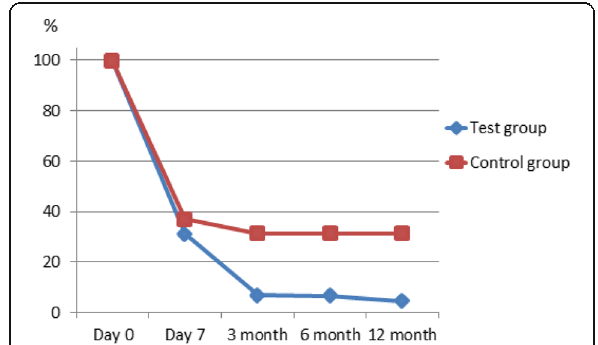
Fig. 1 Changes over time in the percentage incidence of pyuria in the two treatment